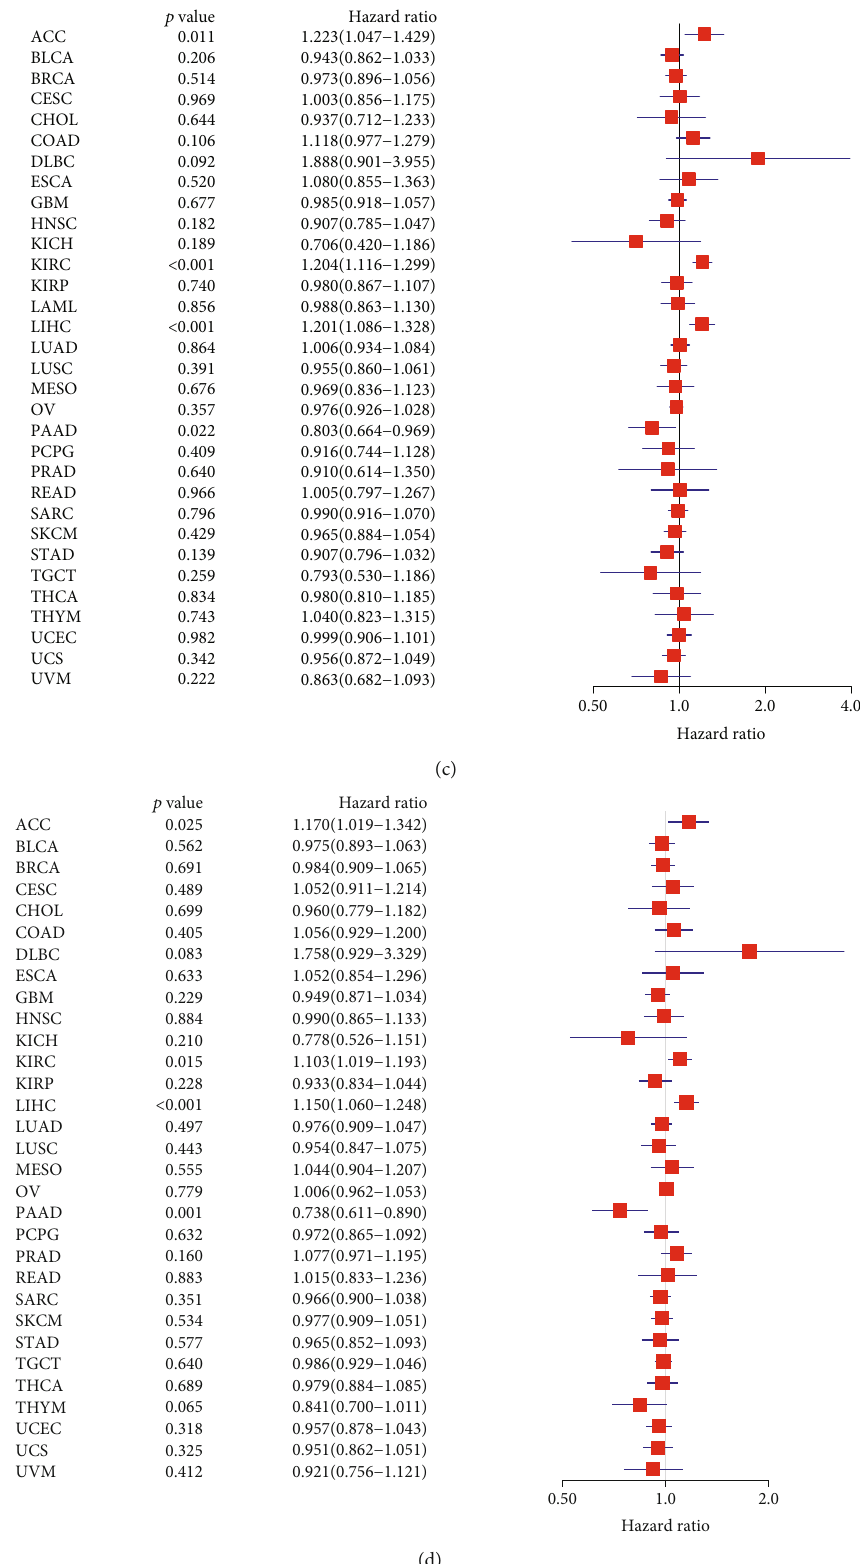
Figure 2: Prognostic value of BACE1-AS in di ff erent tumors. (a, b) Kaplan-Meier curves estimate the OS and PFI di ff erences in pan-cancer. (c, d) OS and PFI di ff erences among pan-cancer analyzed by univariate regression analysis. Only survival curves with signi fi cant di ff erences ( P < 0 : 05 ) were